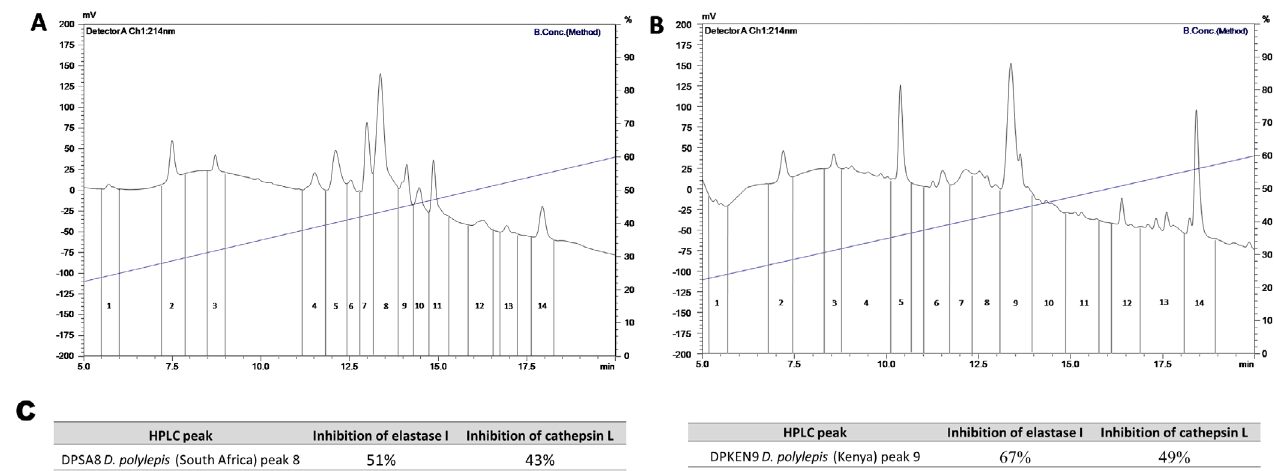
Figure 1. C18-LC-HPLC chromatographic profile and fractions collected from the peptide pool from the venom of Dendroaspis polylepis from (A) South Africa and from (B) Kenya. The blue line represents the concentration of B solution, flow: 1 mL/min. (C) Percentage of inhibition of catalytic activities of elastase-1 and